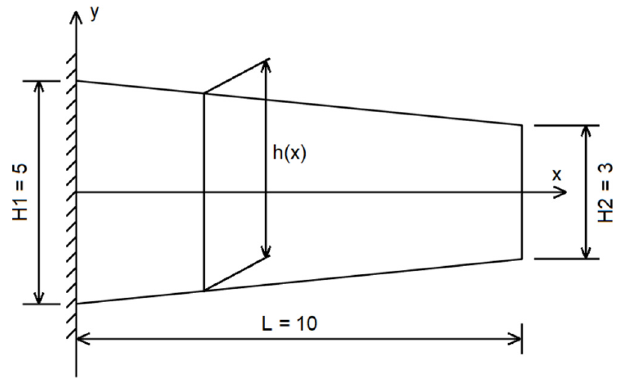
Figure 2. A cantilever beam with a variable cross-section.